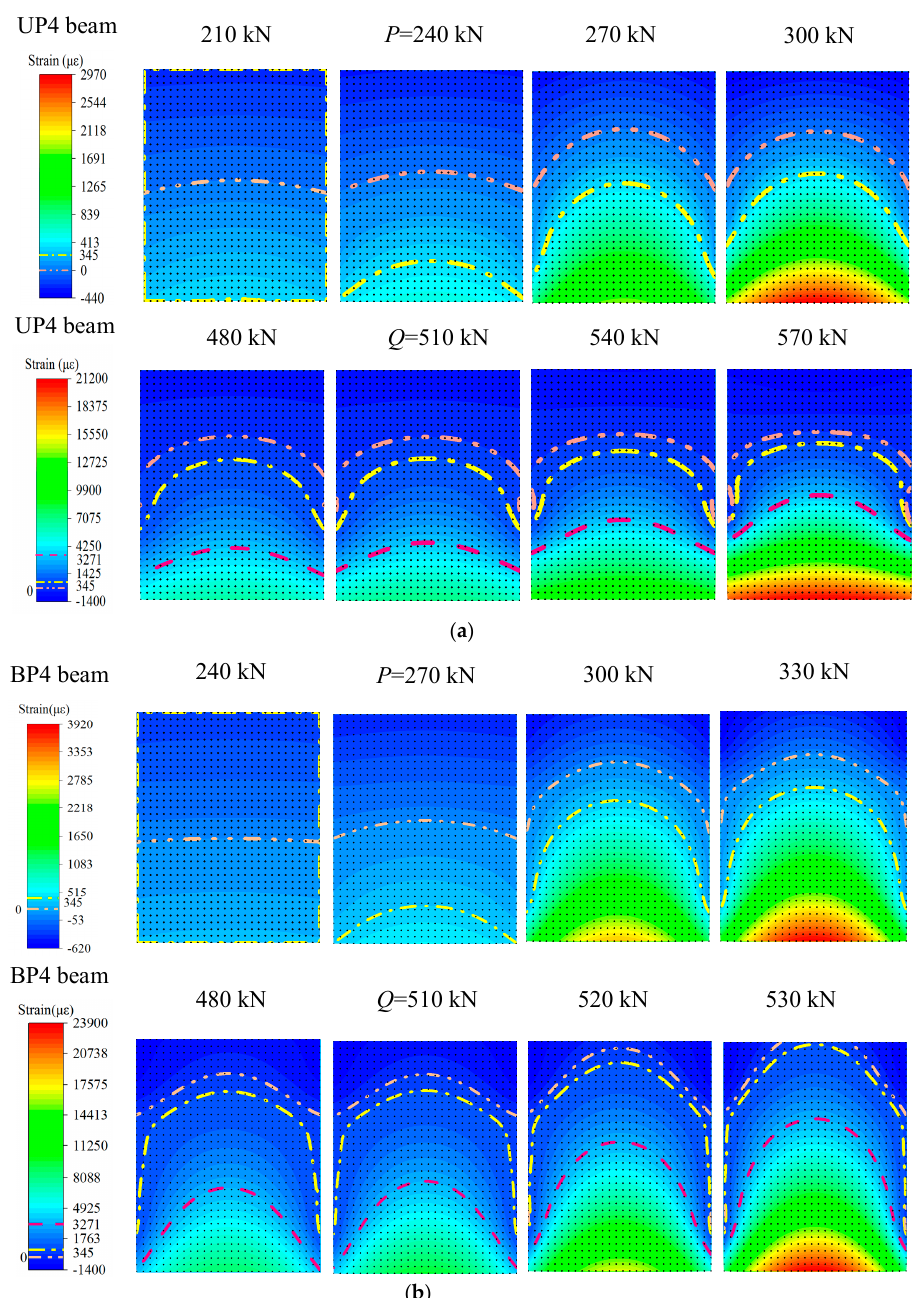
Figure 11. The strain fields diagrams of unbonded No. 4 beam ( UP4): ( a ) the strain fields around characteristic point P ; ( b ) the strain fields around characteristic point Q.